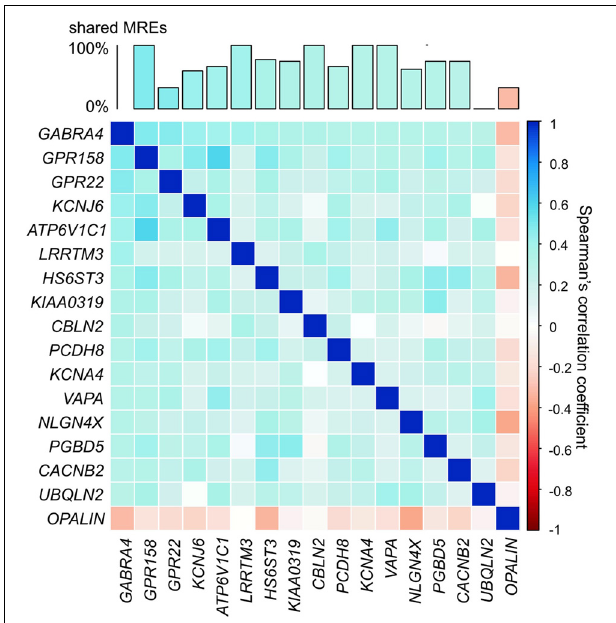
FIGURE 5 | GABRA4- subnetwork. Example of gene in ion channel/transporter network. Correlation matrix of ion channel/transporter genes significantly correlated with GABRA4 ( α = 0 . 05, Bonferroni corrected, pairwise Spearman’s correlation). Bar chart shows percentage of MREs GABRA4 shares with every other gene in GABRA4